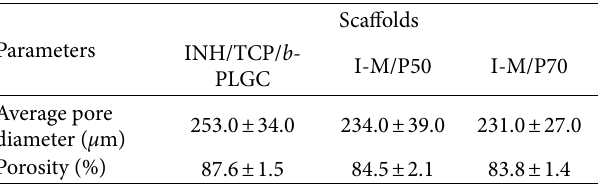
Table 2: Pore parameters of INH-loaded b -PLGC scaffolds with different contents of microparticles.